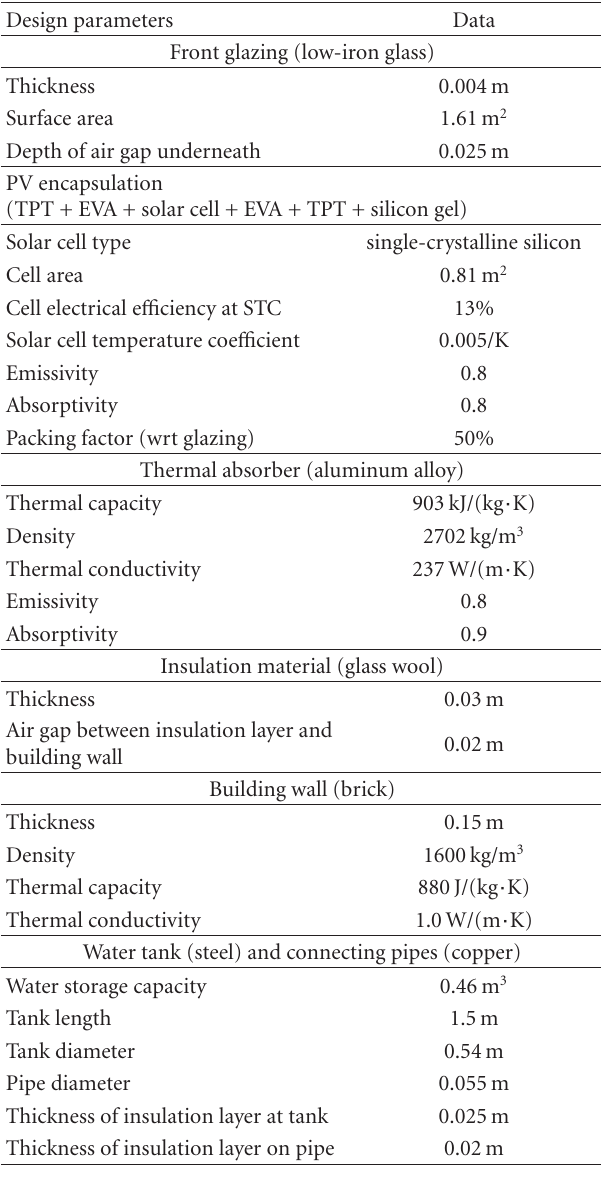
Table 2: Collector and technical design data of BiPV/T